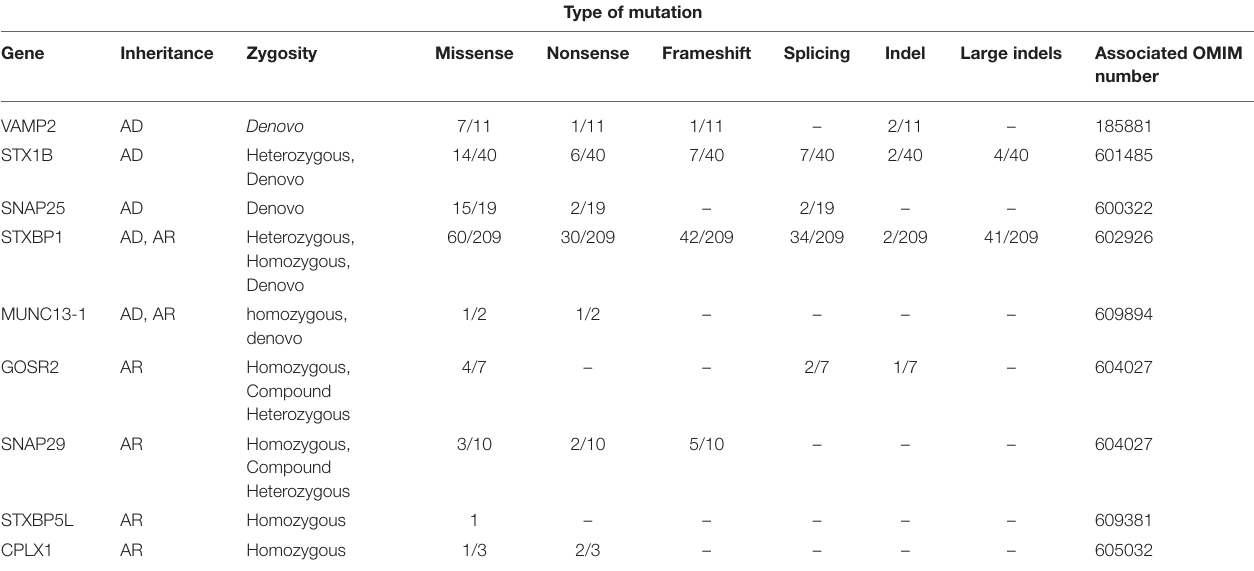
TABLE 1 | Mutations in SNARE proteins encoding